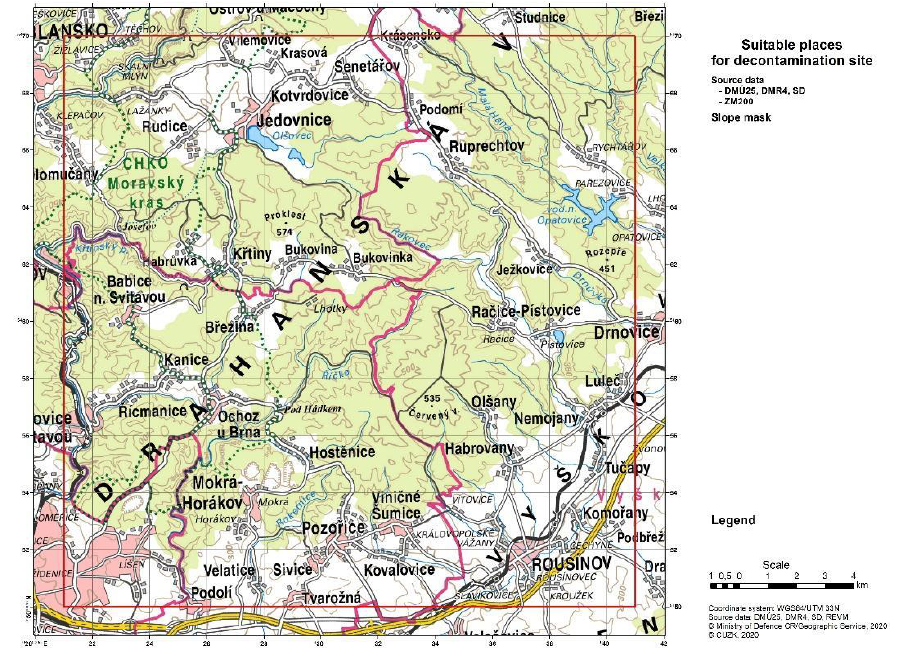
Figure 1. Area of responsibility for the analysis of the possibility of decontamination site (DS) deployment.